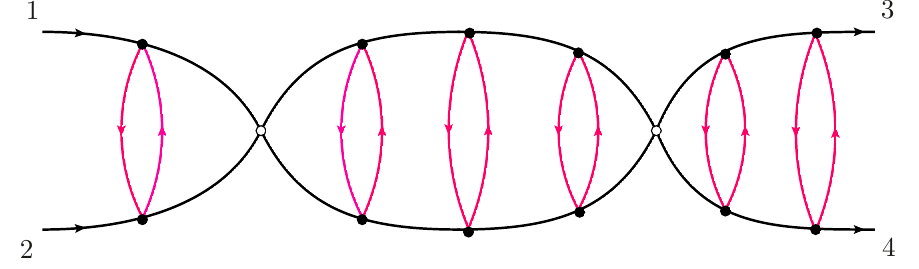
Figure 1 . Feynman diagrams contributing to the scattering amplitude limit. Incoming and outgoing black lines denote scalar particles X and ¯ X , respectively. In a similar fashion, red lines denote scalars Z and ¯ Z . Grey blob represents the sum of single- and double-trace vertices.